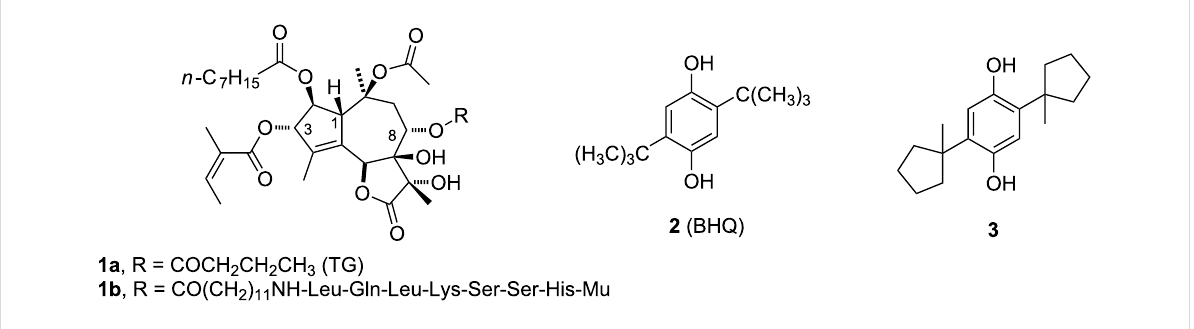
Figure 1: Thapsigargin- and hydroquinone-based SERCA inhibitors.